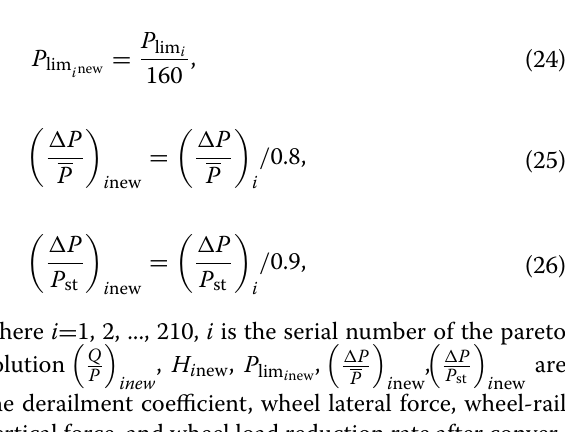
Figure 16 Pareto-optimal front